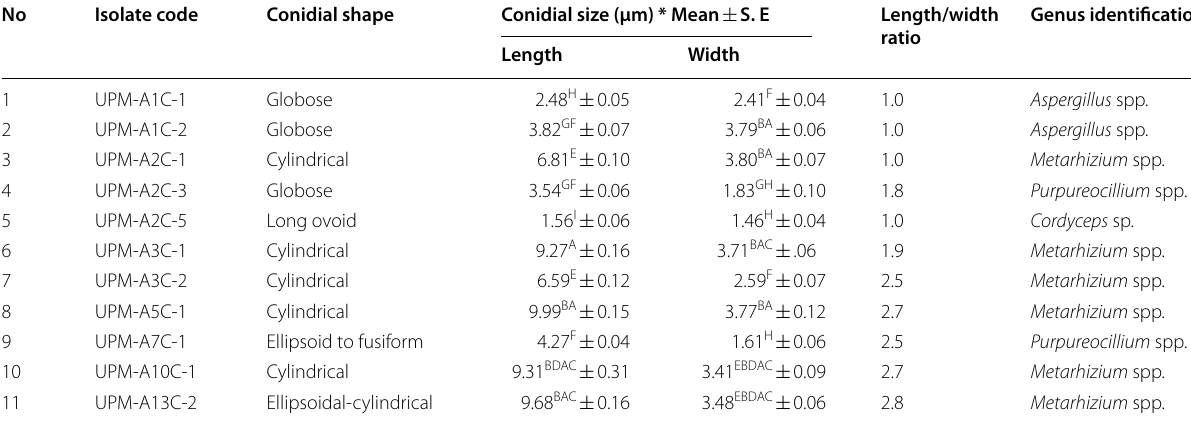
Key; Mean in columns with the same letter are not significantly different at α < 0.05, Tukey’s test for width and length *Mean of 30